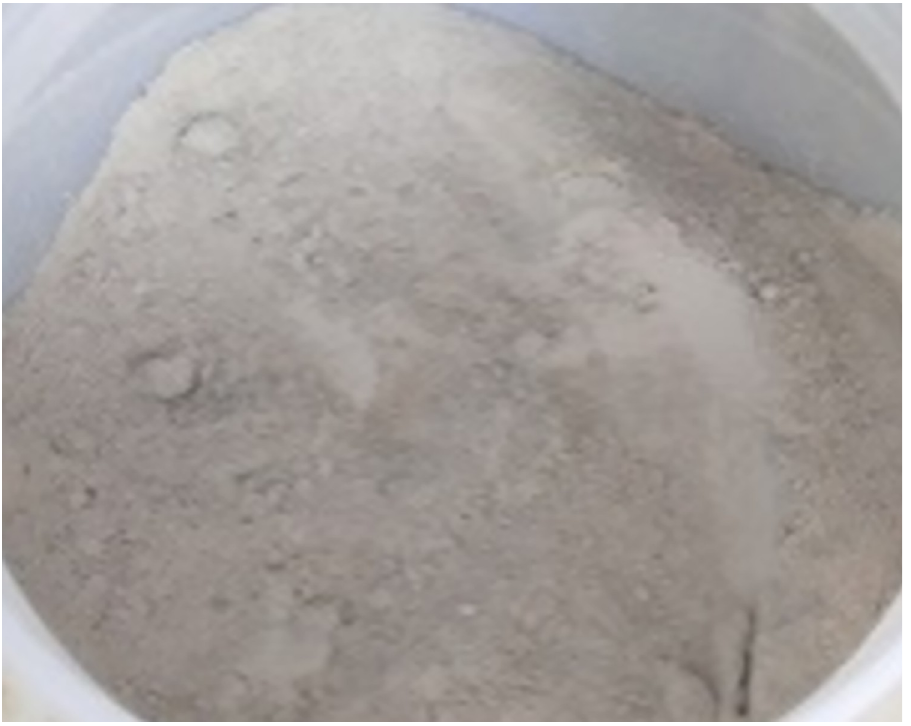
Fig 2. Sulfur building gypsum and